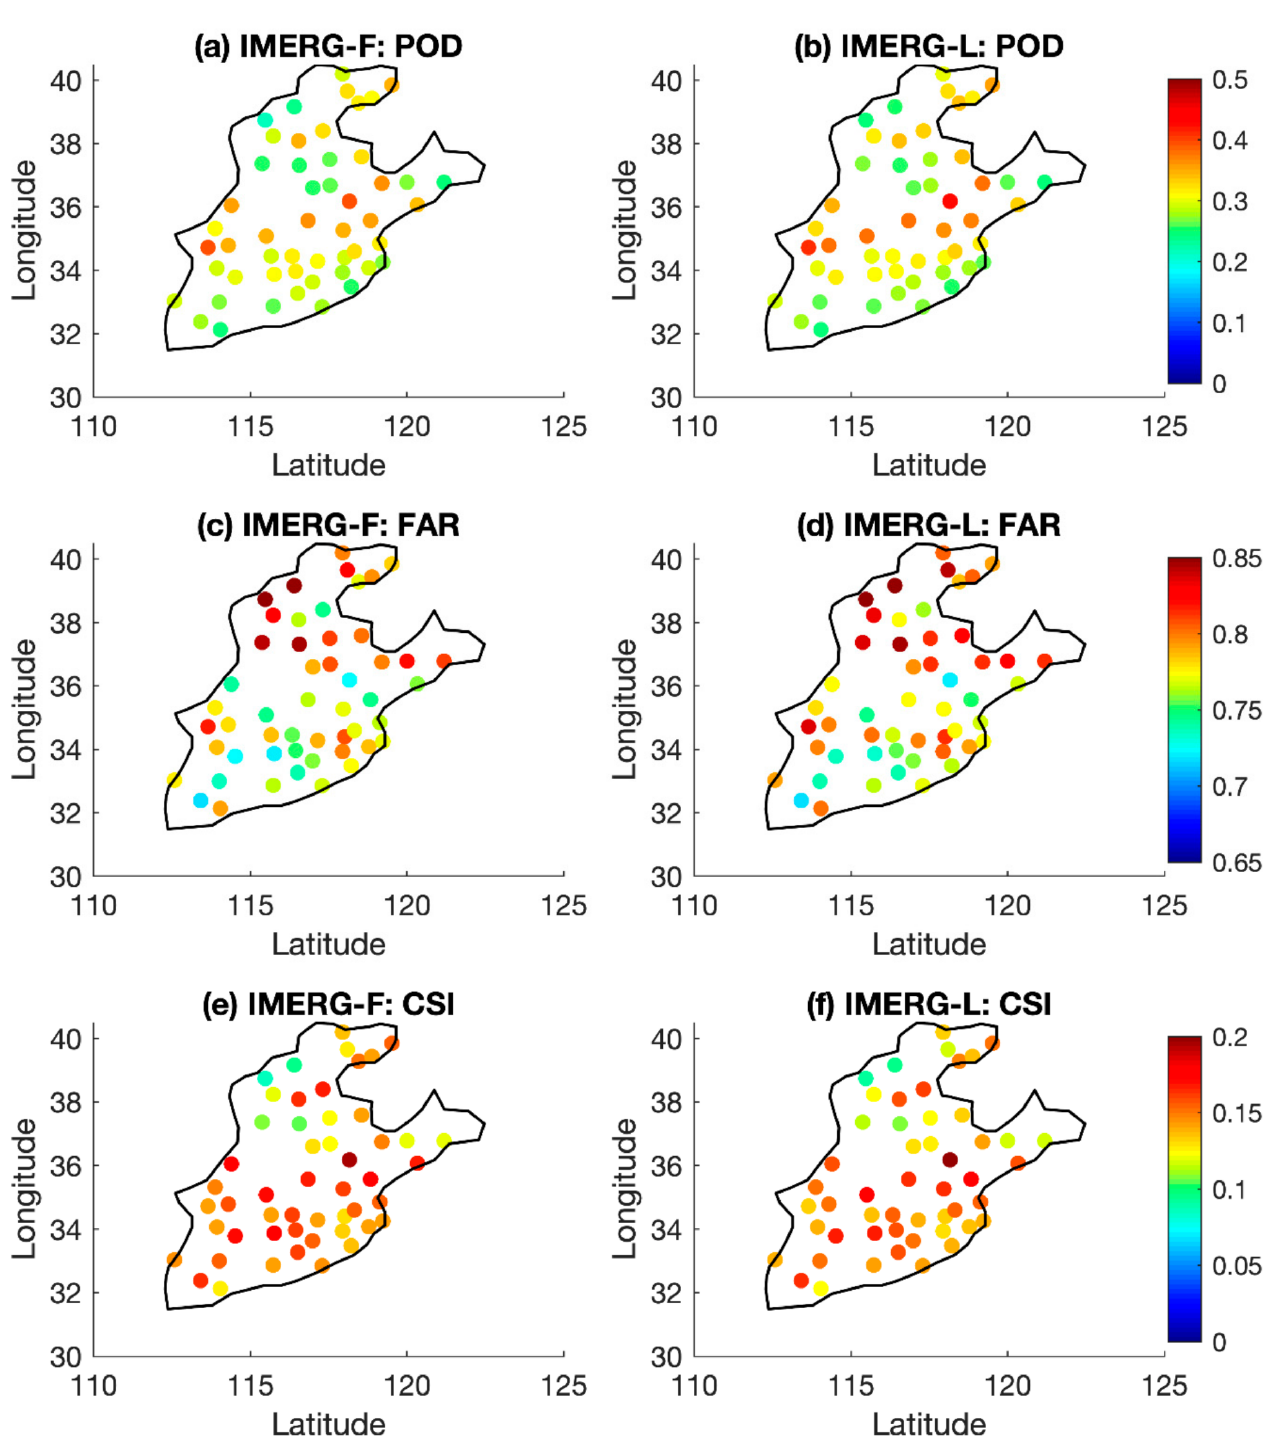
Figure 4. The distributions of POD, FAR, and CSI for the IMERG-F and IMERG-L precipitation products at the hourly